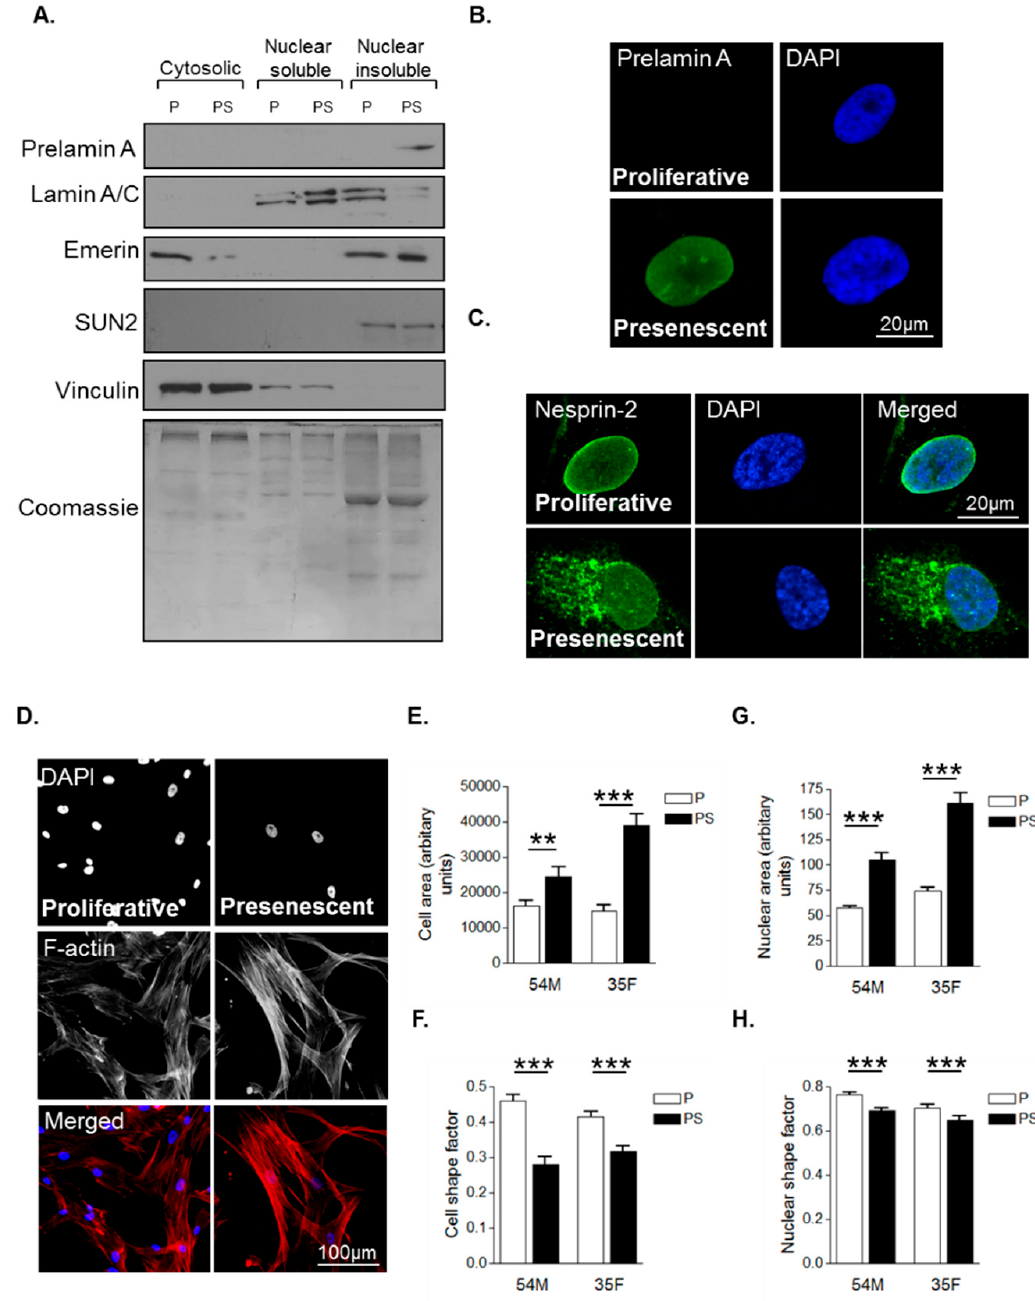
Figure 1. Characterisation of morphological changes during vascular smooth muscle cell (VSMC) ageing. ( A ) Western blot (WB) of cytoplasmic, nuclear soluble and nuclear insoluble fractionations of proliferative (P) and presenescent (PS) VSMCs; Representative confocal images of proliferative and presenescent VSMCs stained with ( B ) prelamin A (green) and 4’,6-diamidino-2-phenylindole (DAPI) (blue); ( C ) nesprin-2 CH3 (green) and DAPI (blue); ( D ) Rhodamine phalloidin (red) and DAPI (blue). Graphs show ( E ) cell area, ( F ) cell shape factor, ( G ) nuclear area and (H) nuclear shape factor of proliferative (P) and presenescent (PS) VSMCs based on the combined measurement of >300 VSMCs from two different isolates (54M, 35F) in three independent experiments (** p ≤ 0.01 and *** p ≤ 0.0001).